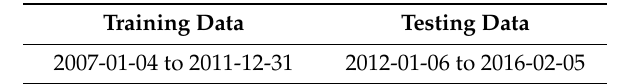
Table 1. Ranges of the training and testing